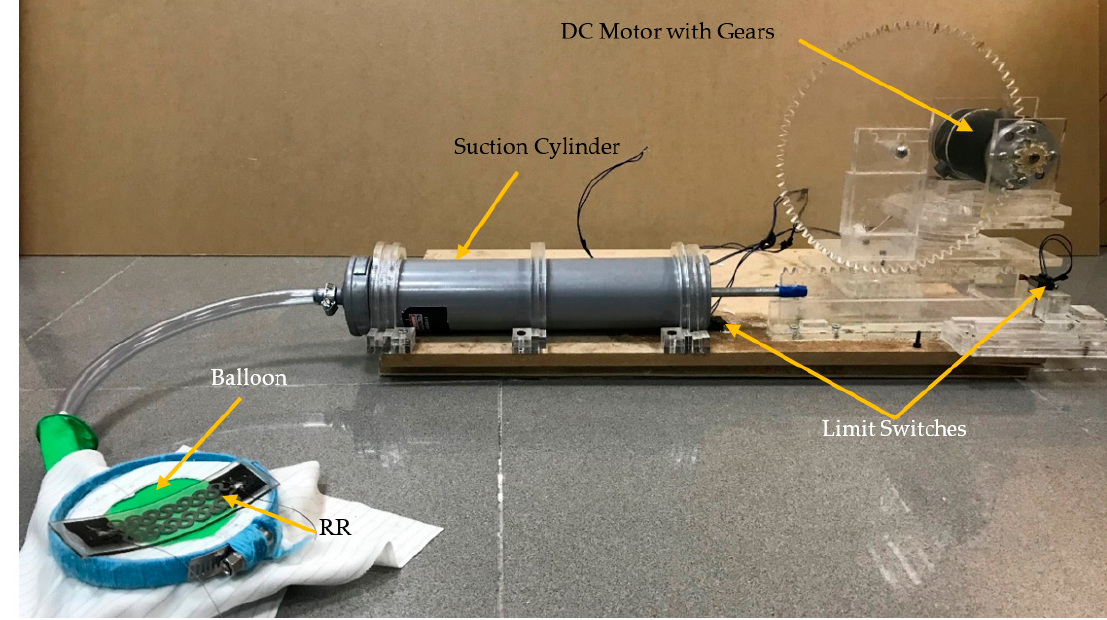
Figure 9. Respiration simulator prototype.